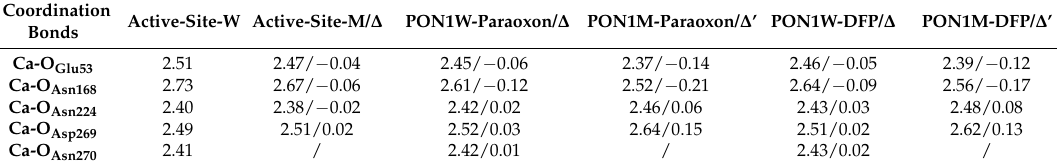
Table 1. Coordination bond lengths of the optimized geometries for the Active-site-W, Active-site-M, PON1W-Paraoxon, PON1M-Paraoxon, PON1W-DFP, and PON1M-DFP models. “ ∆ ” is the difference relative to the Active-site-W model. Distances are in angstroms.